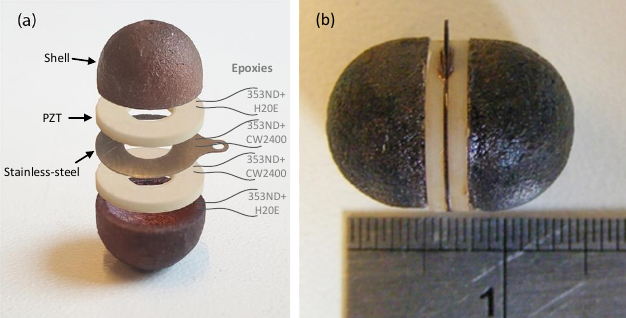
Figure 5. The components of the transducer before integration ( a ) and after integration as a functional transducer ( b ).